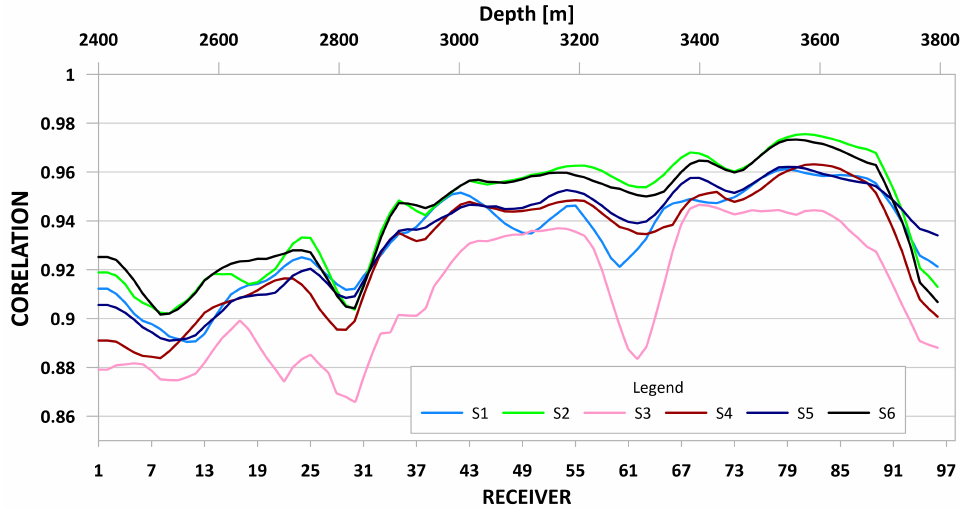
Figure 7. Correlation between records for one shot point. Each line represents the correlation between one sweep and the pilot, calculated as the average of all sweeps on the point (see in [5]